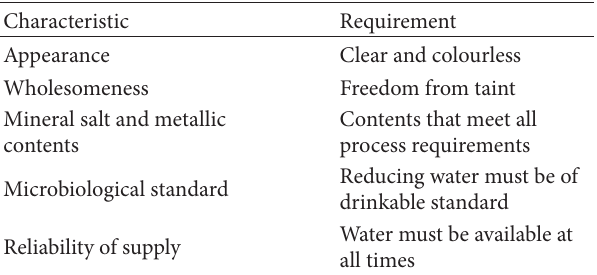
Table 1: Characteristics and corresponding requirements of Whisky production.